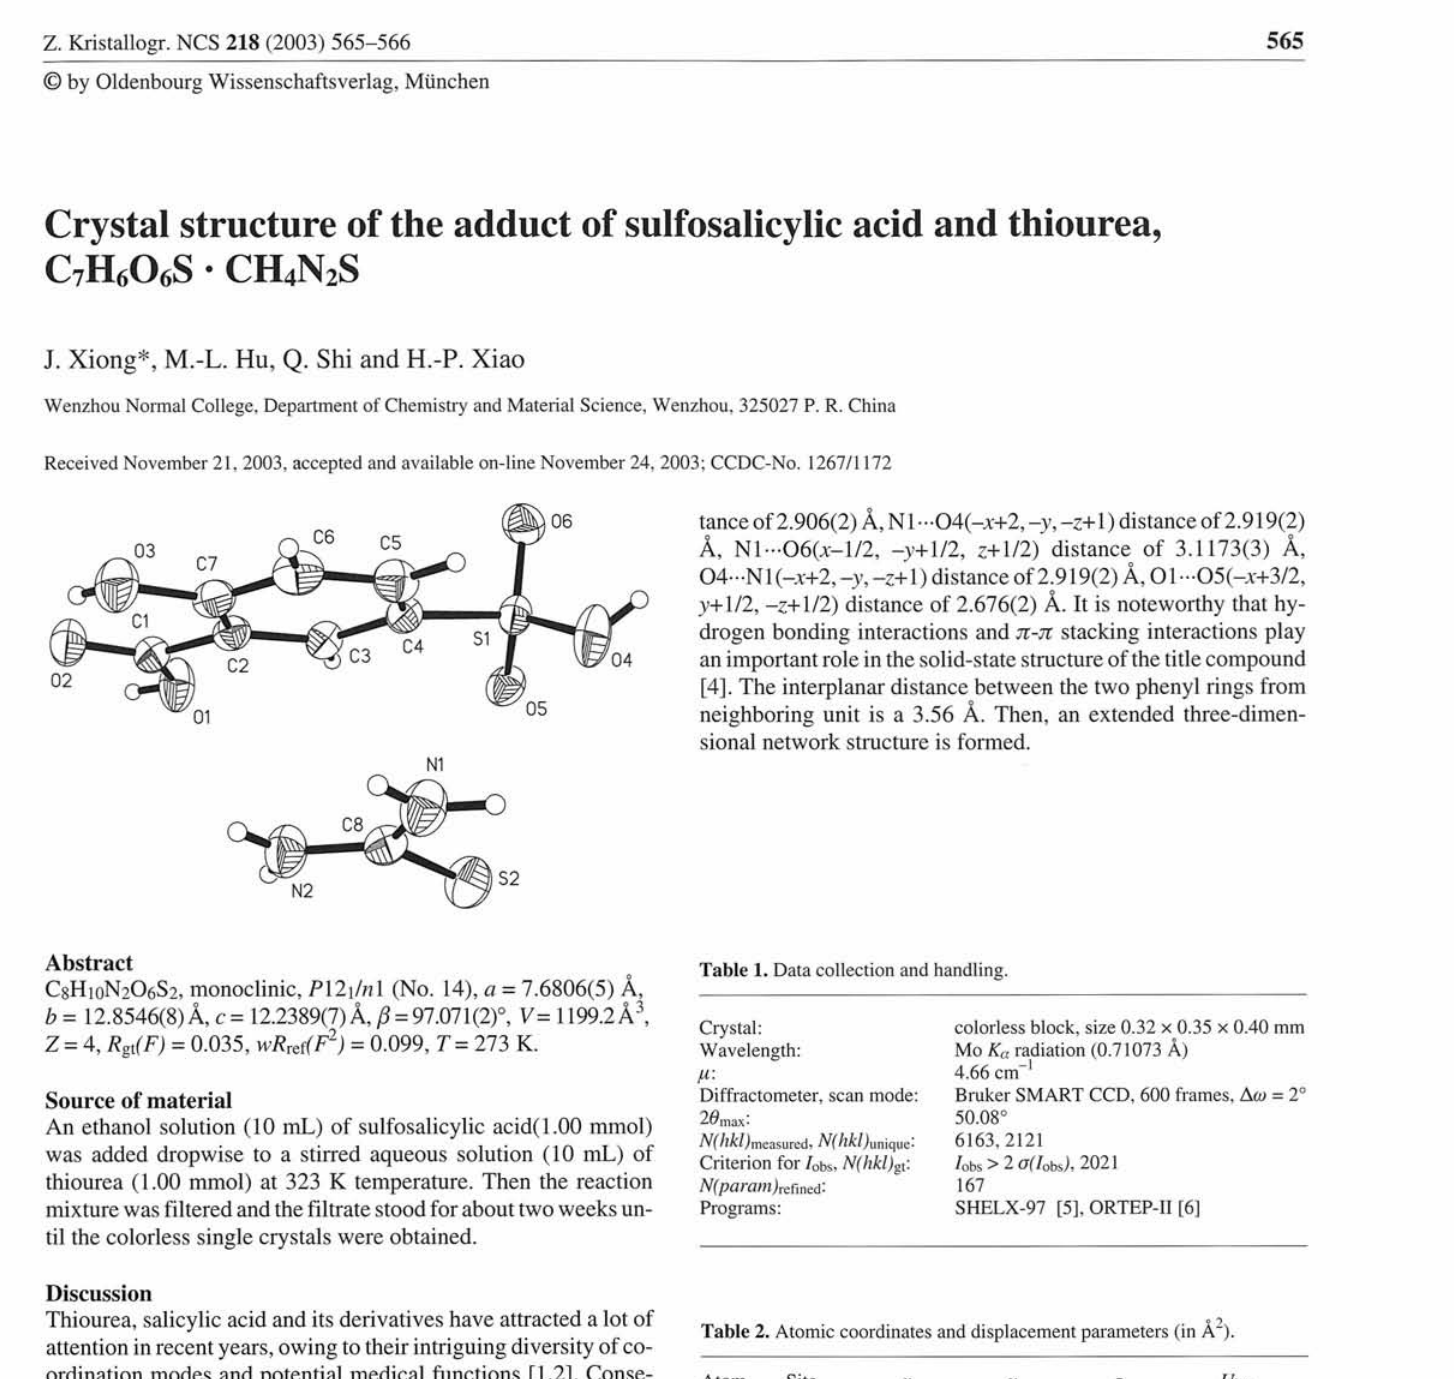
Table 2. Atomic coordinates and displacement parameters (in